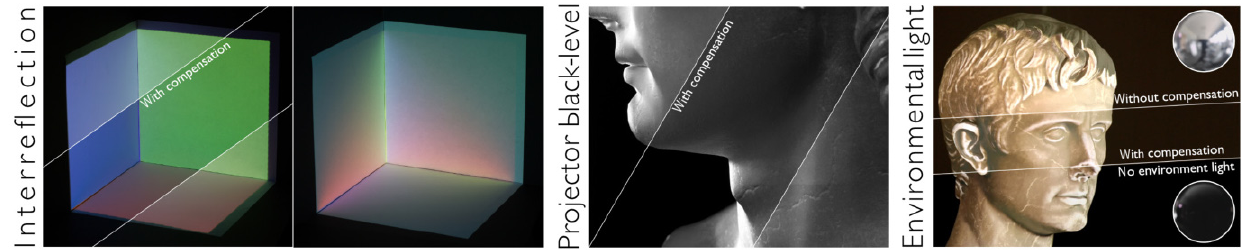
Fig. 1 Left: correcting for interreflection in the corner of a box, where the sides are colored using projection mapping, along with an image of the indirect light. Middle: correcting for the black-level of the projectors. Note how the brightness discontinuity on the neck disappears. Right: correcting for daylight. For reference, projection without environmental light is shown below. Note the corresponding light probes. All images in this paper are pictures of real projections, captured with a